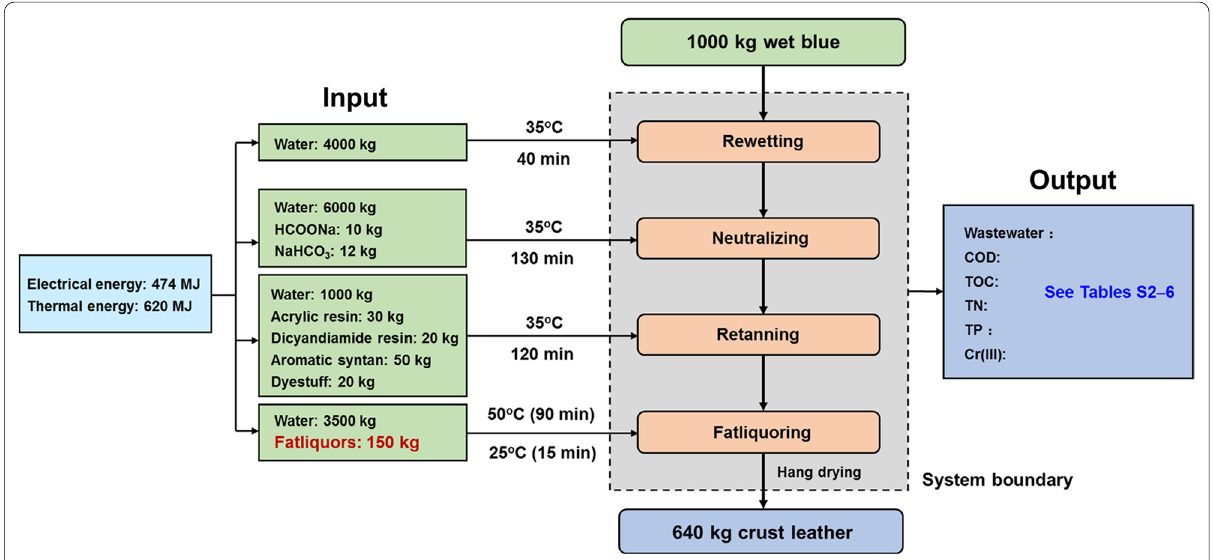
Fig. 3 Energy, chemical, and effluent inventories for fatliquor use